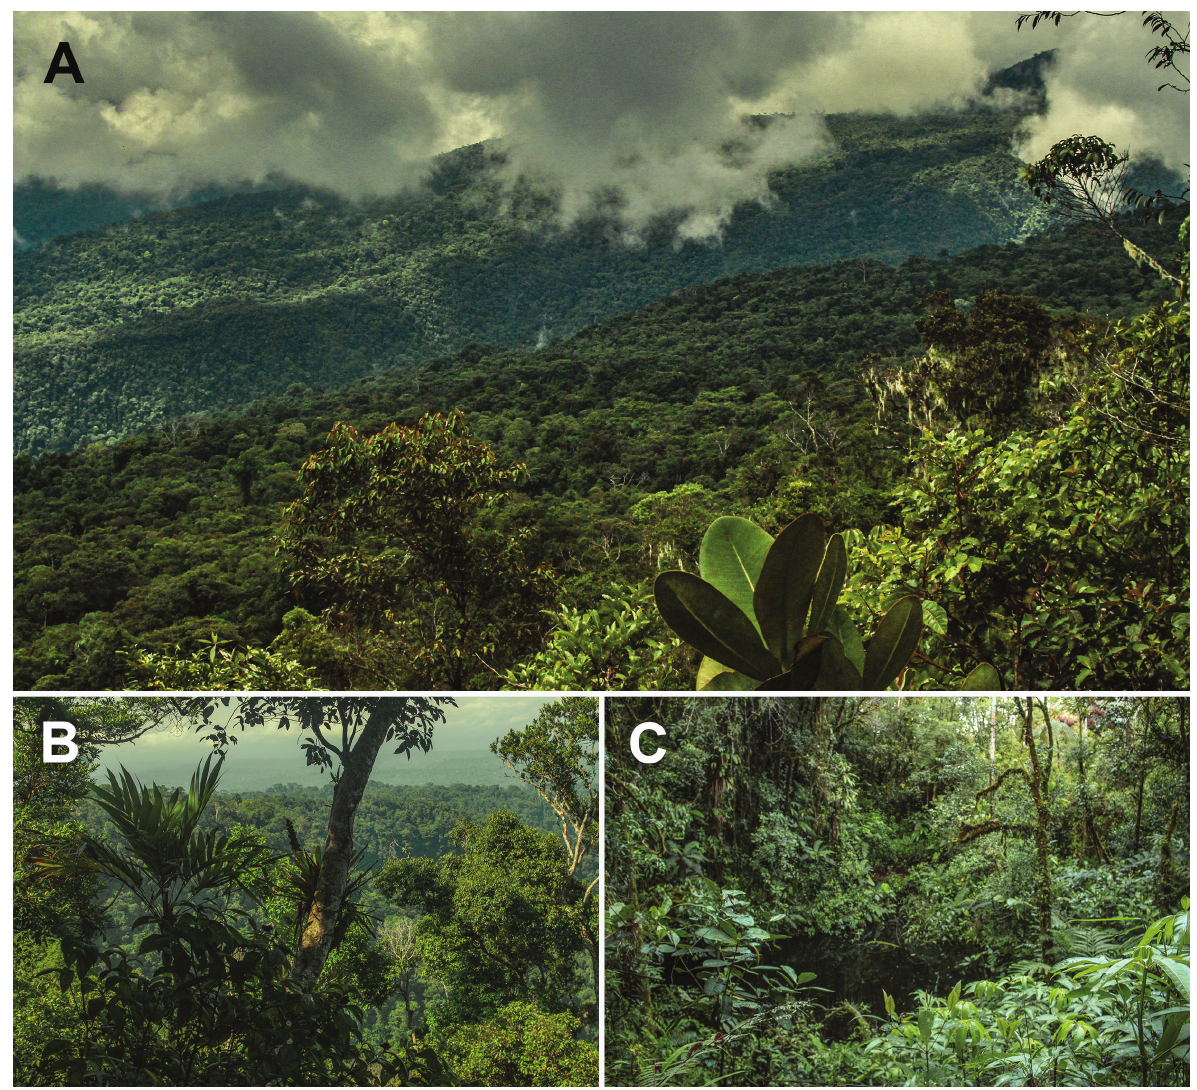
Figure 6. Habitat in the localities where Pristimantis sira sp. nov. occurs: ( A ) Panoramic view of the Montane forests in El Sira Commu- nal Reserve; ( B ) forest in Campamento La Cumbre; ( C ) forest in Campamento Peligroso (type locality). Photographs by Germán Table 1. Range and average (± standard deviation) measurements (in mm) of specimens of the type series of Pristimantis sira sp. nov. and related cruciform eye’s montane species of the Pristimantis cruciocularis group. Pristimantis sira sp. nov.